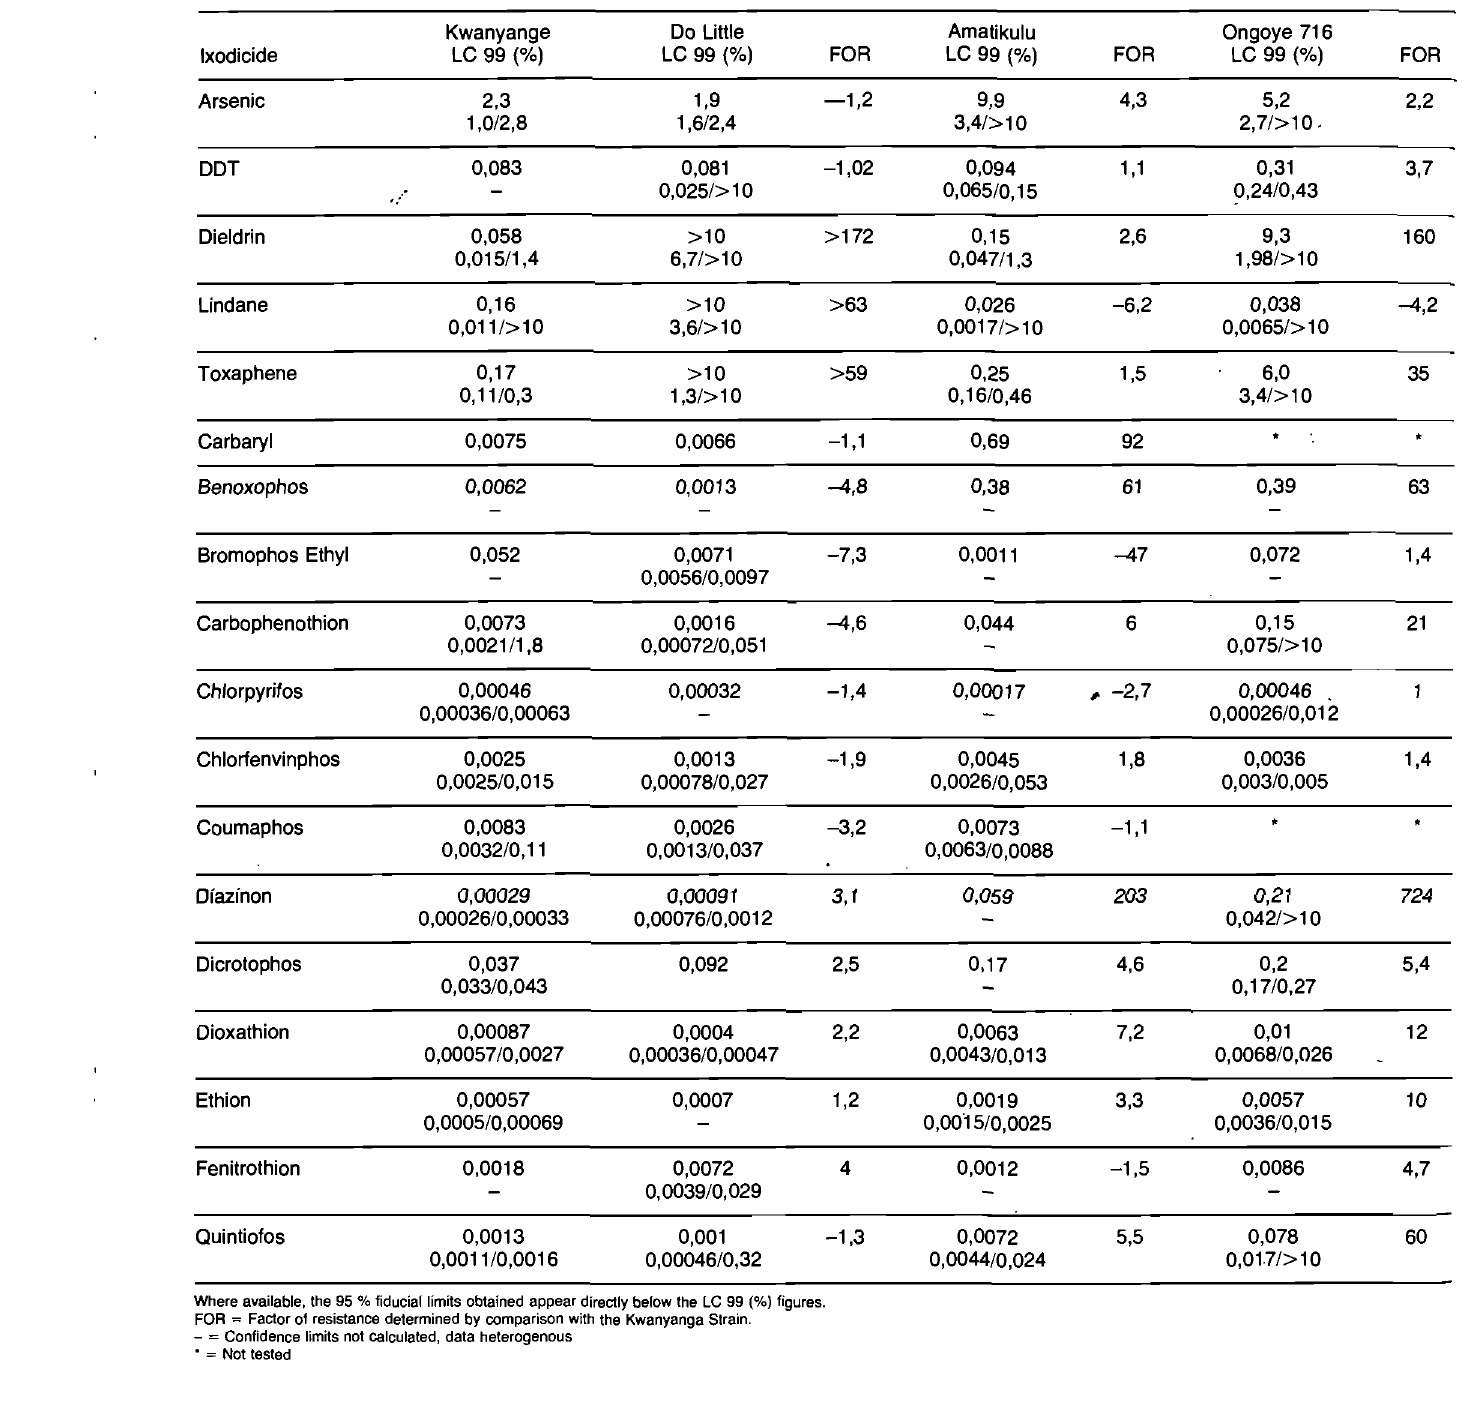
Table 2: A COMPARISON OF THE SUSCEPTIBILITY OF LAVAE OF THE KWANYANGA, DO UTILE, AMATIKULU AND ONGOYE 716 STRAINS OF BOOPHILUS MICROPLUS Kwanyange Do Little Amatikulu Ongoye 716 Ixodicide LC 99 (%) LC 99 (%) FOR LC 99 (%) FOR LC 99 (%) FOR